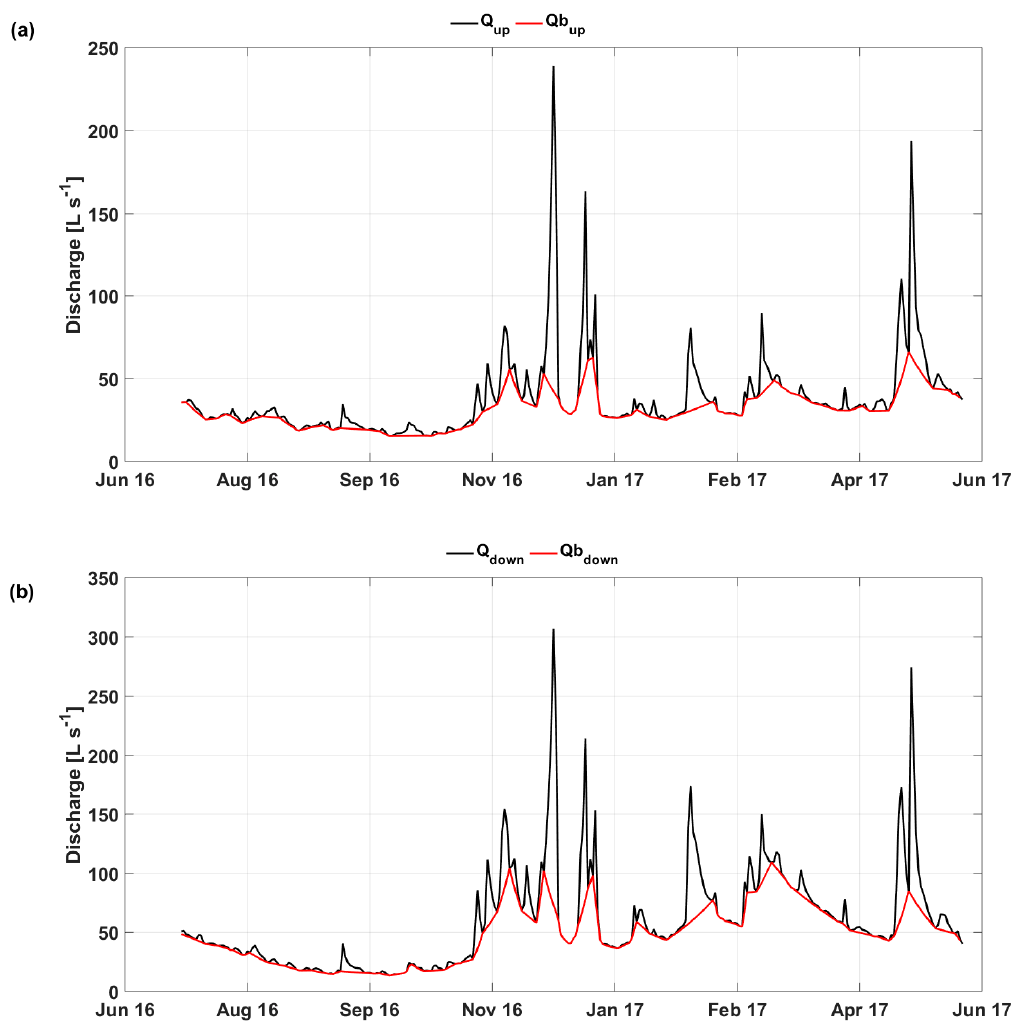
Figure 8. Stream discharge (Q) (including runoff) and baseflow (Qb) over time at the gauging station ( a ) upstream (wetland sub-reach) and ( b ) downstream (meadow sub-reach).